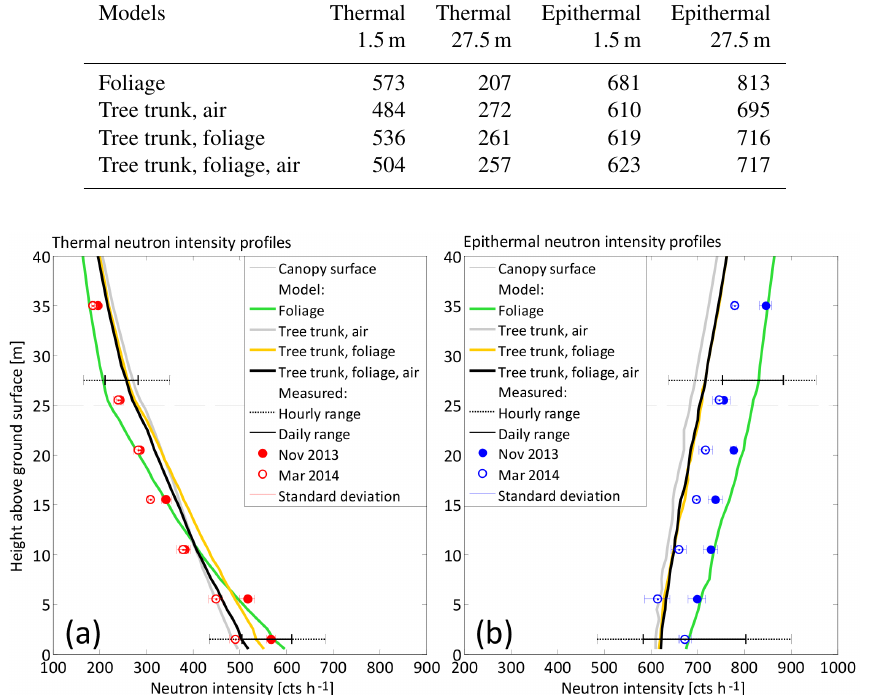
Figure 3. Measured and modeled (a) thermal and (b) epithermal neutron intensity profiles at Gludsted plantation. Hourly and daily ranges of variation of thermal and epithermal neutron intensities at ground and canopy level for the period 2013–2015. Gludsted plantation is modeled using four different forest canopy conceptualizations (see Fig.